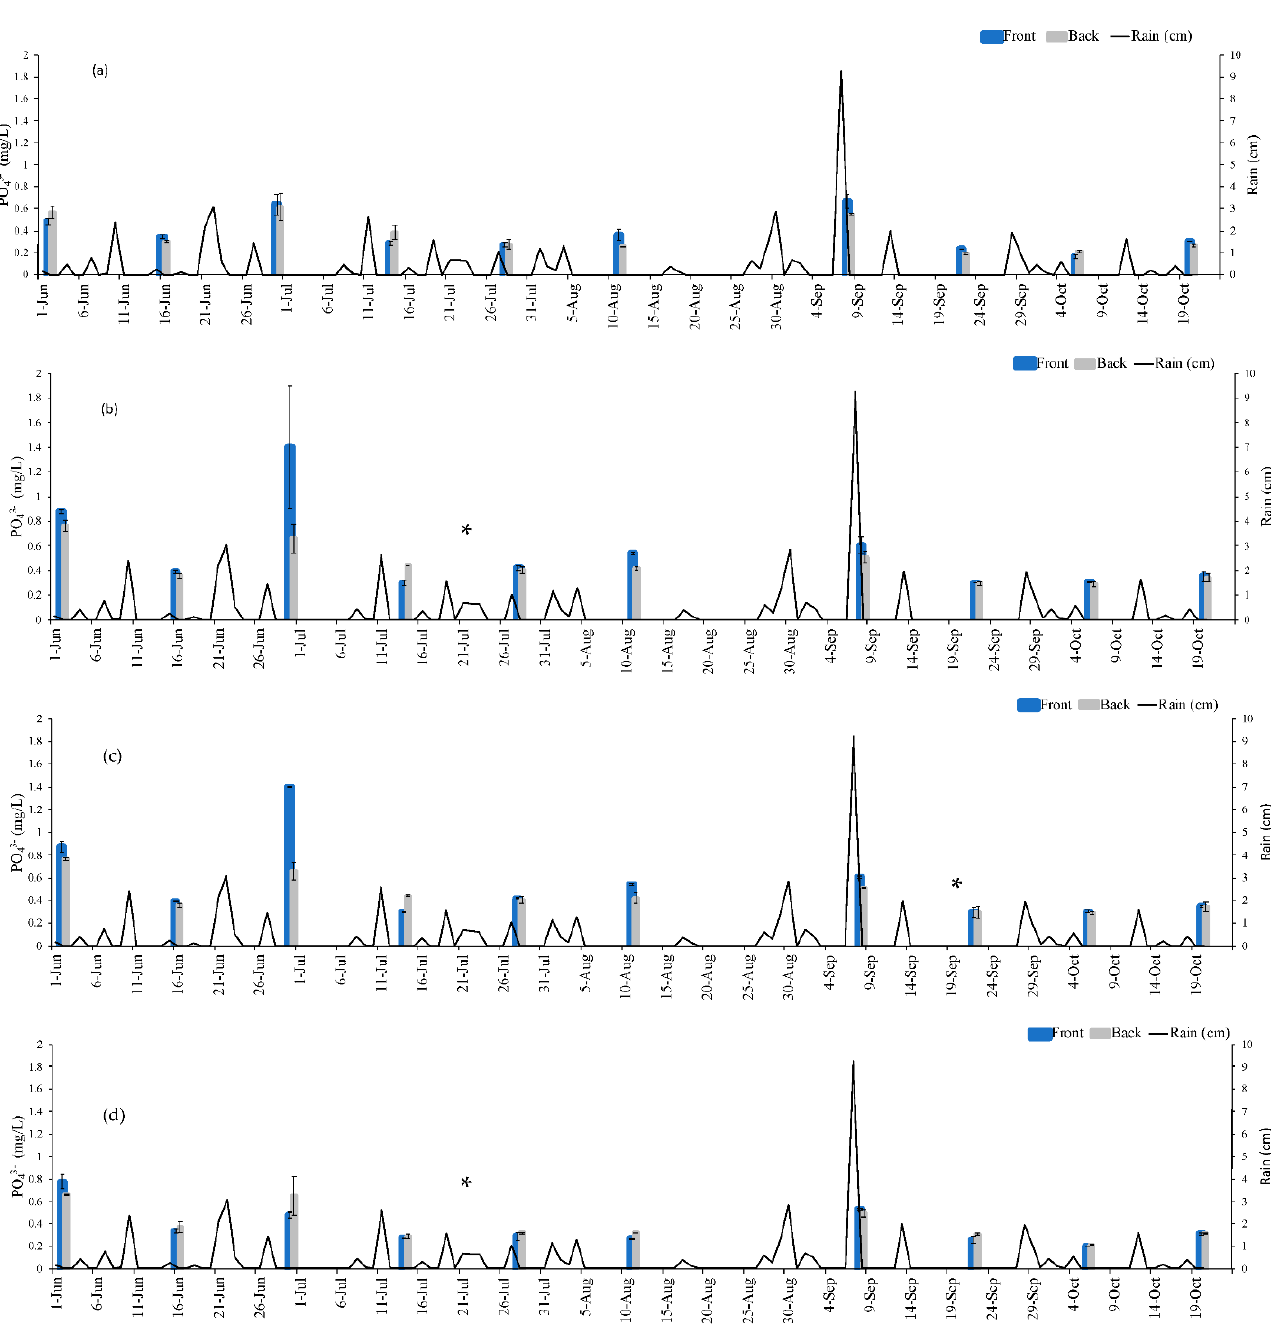
Figure 5. mg PO 4 3 − /L immediately in the front and back of gate during sampling events during 2020. ( a ) Gate 1, ( b ) Gate 2, ( c ) Gate 3 and ( d ) Gate 4. * denotes the date when WTR in cartridges was changed. Error bars are standard deviation of triplicate samples.